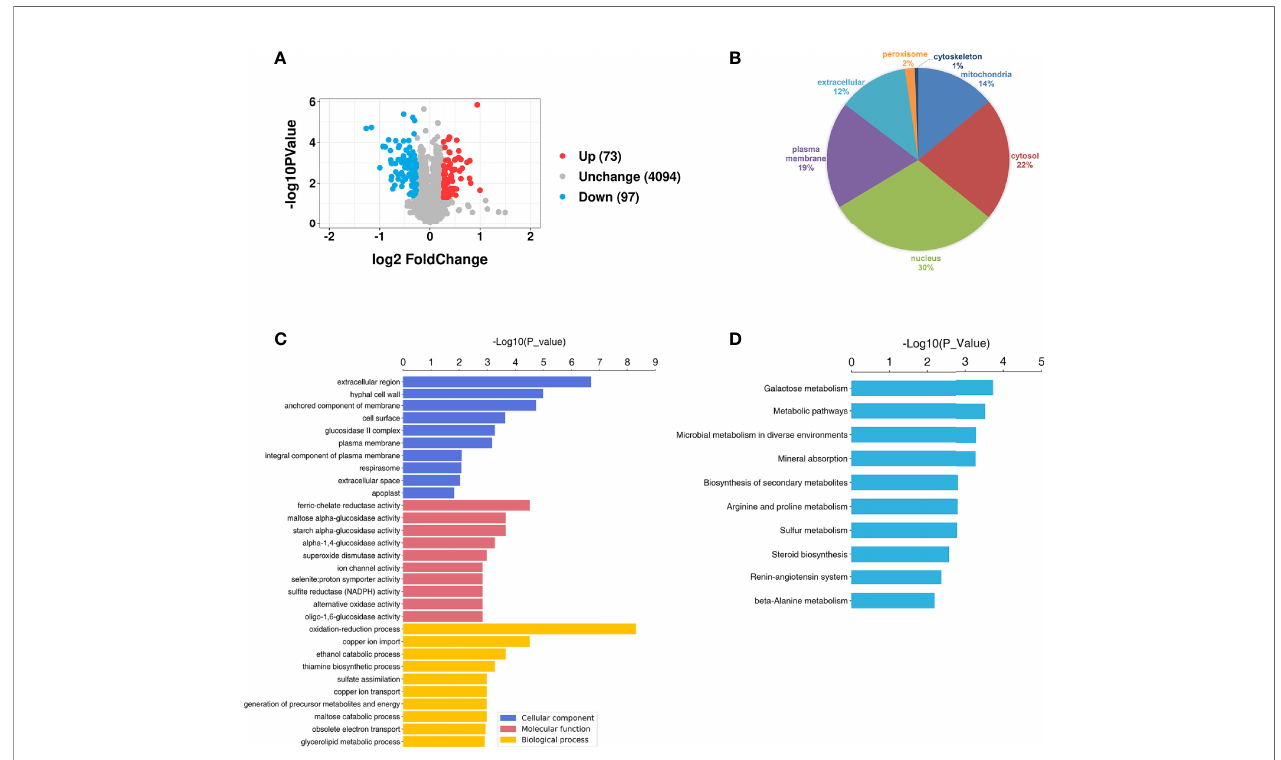
FIGURE 3 | Proteomic analysis of C. albicans. (A) Volcano plot of differentially expressed C. albicans proteins. The red spots represent 73 proteins that were upregulated in the S. mutans MV group, and the blue spots represent 97 proteins that were downregulated in the S. mutans MV group (adjusted P < 0.05, fold